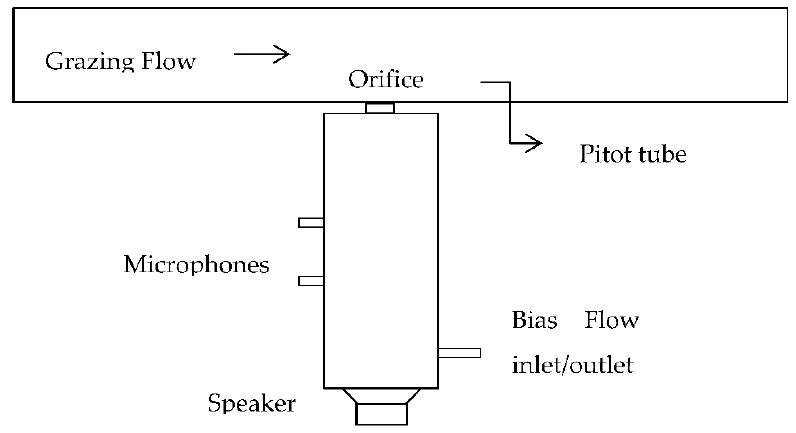
Figure 12. Test rig setup in experiment for the investigation of simultaneous bias/grazing flow effect, Sun et al. [22]. Table 3. Geometric specifications of the orifice liners, Sun et al. [22].